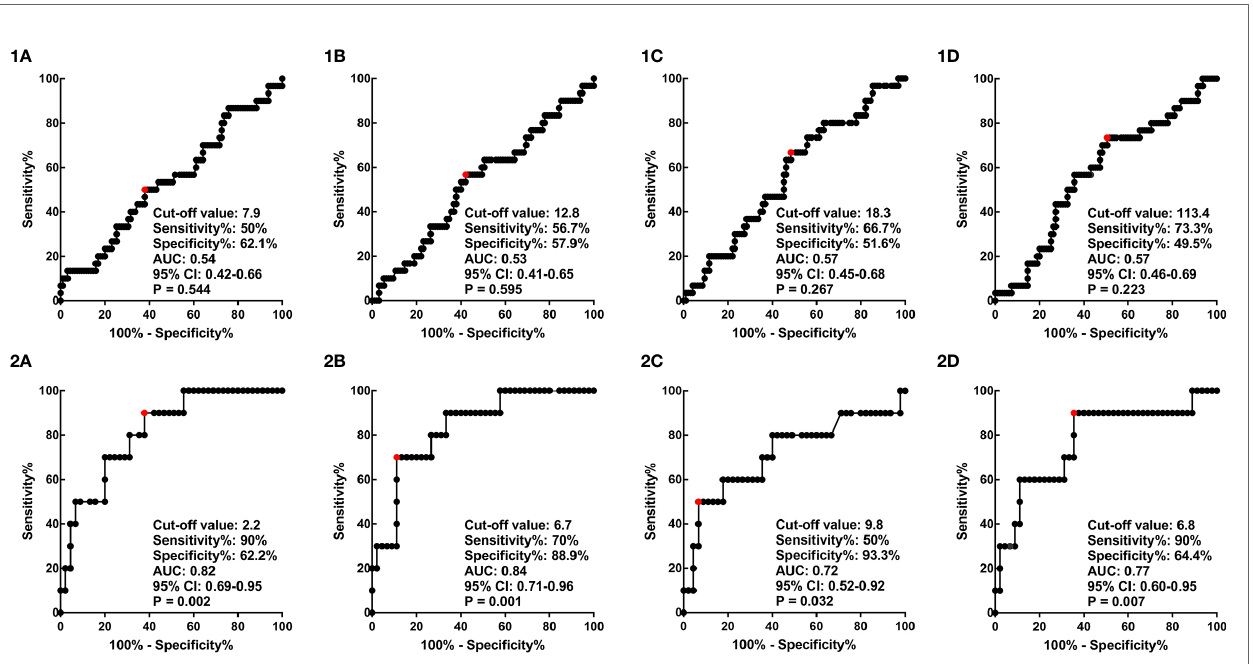
FIGURE 2 | ROC curves of cervical SUVmean (1A) , cervical SUVmax (1B) , cervical MTV (1C) , and cervical TLG (1D) , and ROC curves of LN SUVmean (2A) , LN SUVmax (2B) , LN MTV (2C) , and LN TLG (2D) . ROC, receiver operator characteristic; SUV, standardized uptake value; MTV, metabolic tumor volume; TLG, total lesion glycolysis; LN, lymph node.